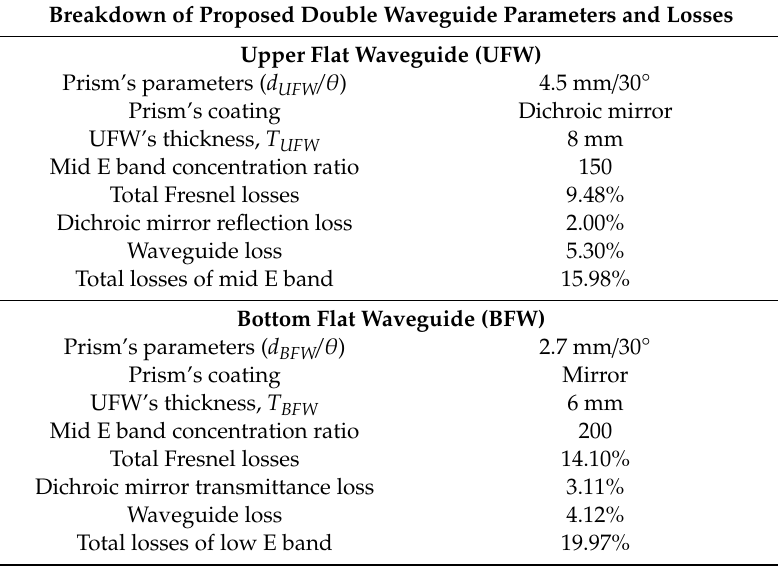
Table 2. Some main parameters of double waveguides and system loss